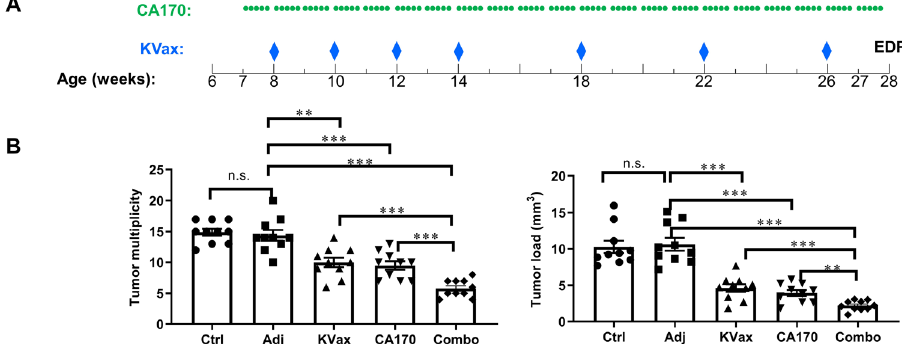
Fig. 1 The combination of CA170 and KVax shows enhanced anti-tumor ef fi cacy in VC-induced lung tumorigenesis. A Experimental design outlining the timing of KVax vaccine treatment, CA170 administration, and experimental endpoint (EDP). B Tumor multiplicity and tumor load quantitation at the experimental endpoint. Data are shown as the mean ± SE, n = 10, * P ≤ 0.05, ** P ≤ 0.01, *** P ≤ 0.001 vs